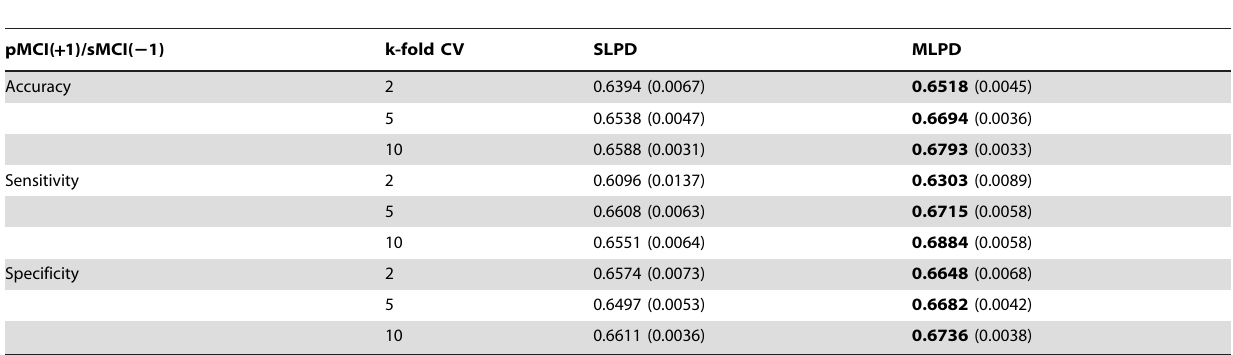
Table 5. Comparison of the classification performance of MLPD and SLPD on task